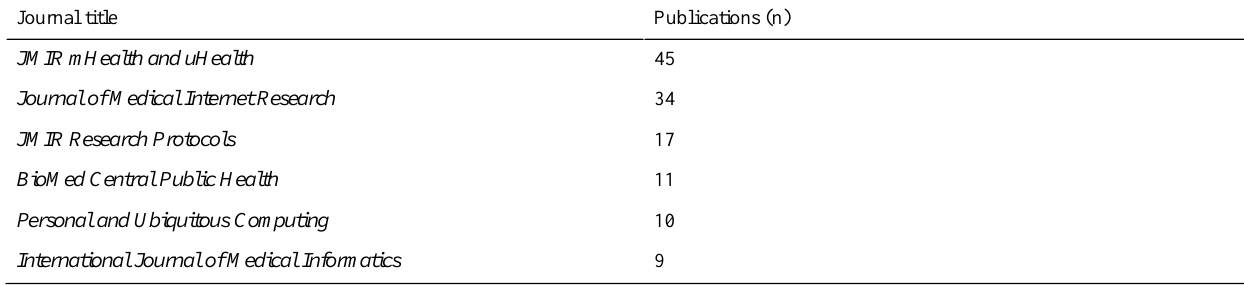
Table 5. List of top journal distribution.